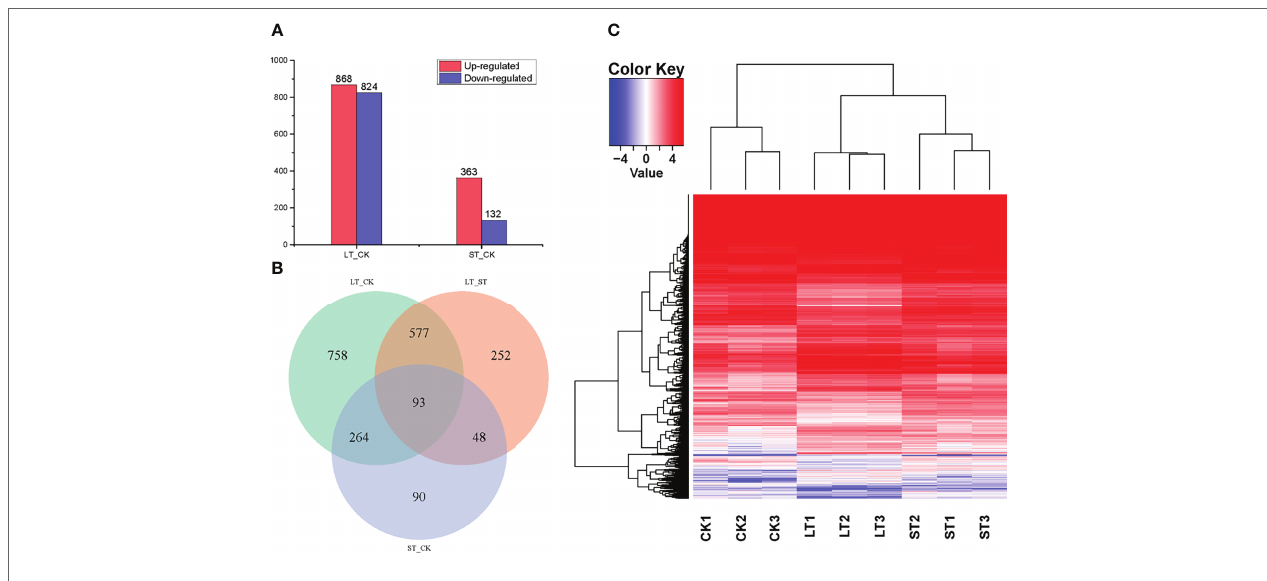
FIGURE 3 | Statistics and analysis of differentially expressed genes (DEGs) among the different treatments. (A) The number of DEGs between the different treatments. (B) Venn diagram shows the overlapping DEGs among of LT vs. CK, LT vs. ST, and ST vs. CK. (C) Heat map analysis of the DEGs among the different treatments; red represents upregulated, and blue represents downregulated. CK, control; ST, short-term acidification; LT, long-term